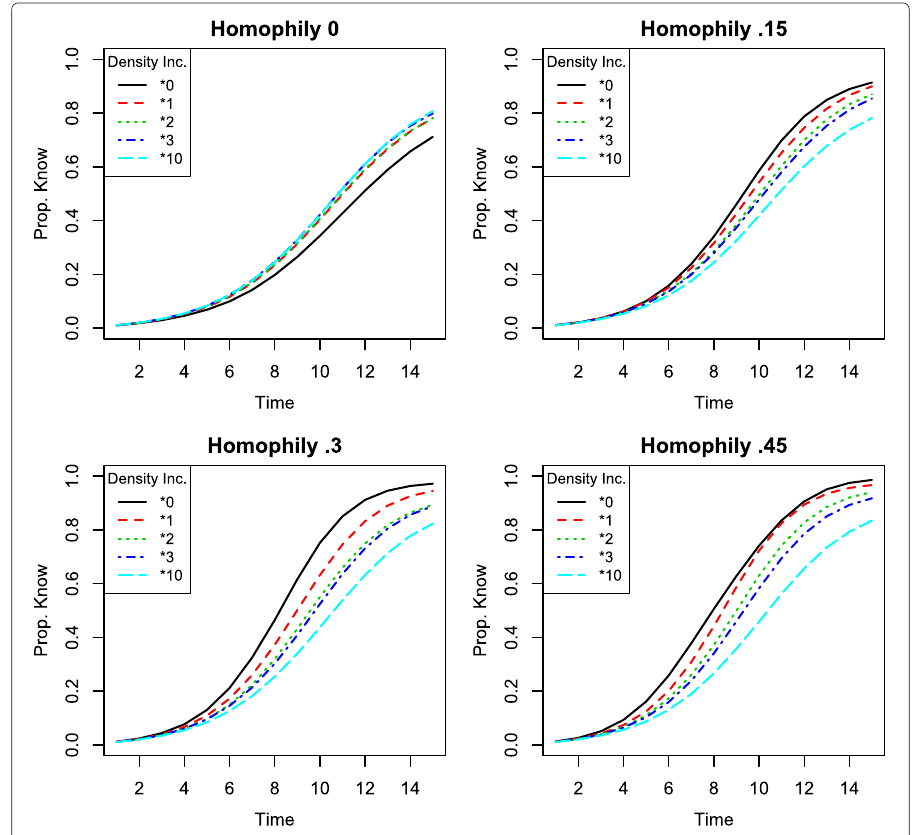
Fig. 2 Proportion of network informed by each timestep in simulated information spread on a network with τ = { τ 1 , τ 2 } , and q τ 1 = q τ 2 = 1 . Simulation parameters set to x = 2, p strong = 1, and p weak = .5. When 2 homophily = 0, random ties will not change neighborhood compositions on average, so the jump effect dominates and increasing density strictly improves information diffusion. At greater values of homophily, increasing density does change neighborhood compositions and strictly impedes information